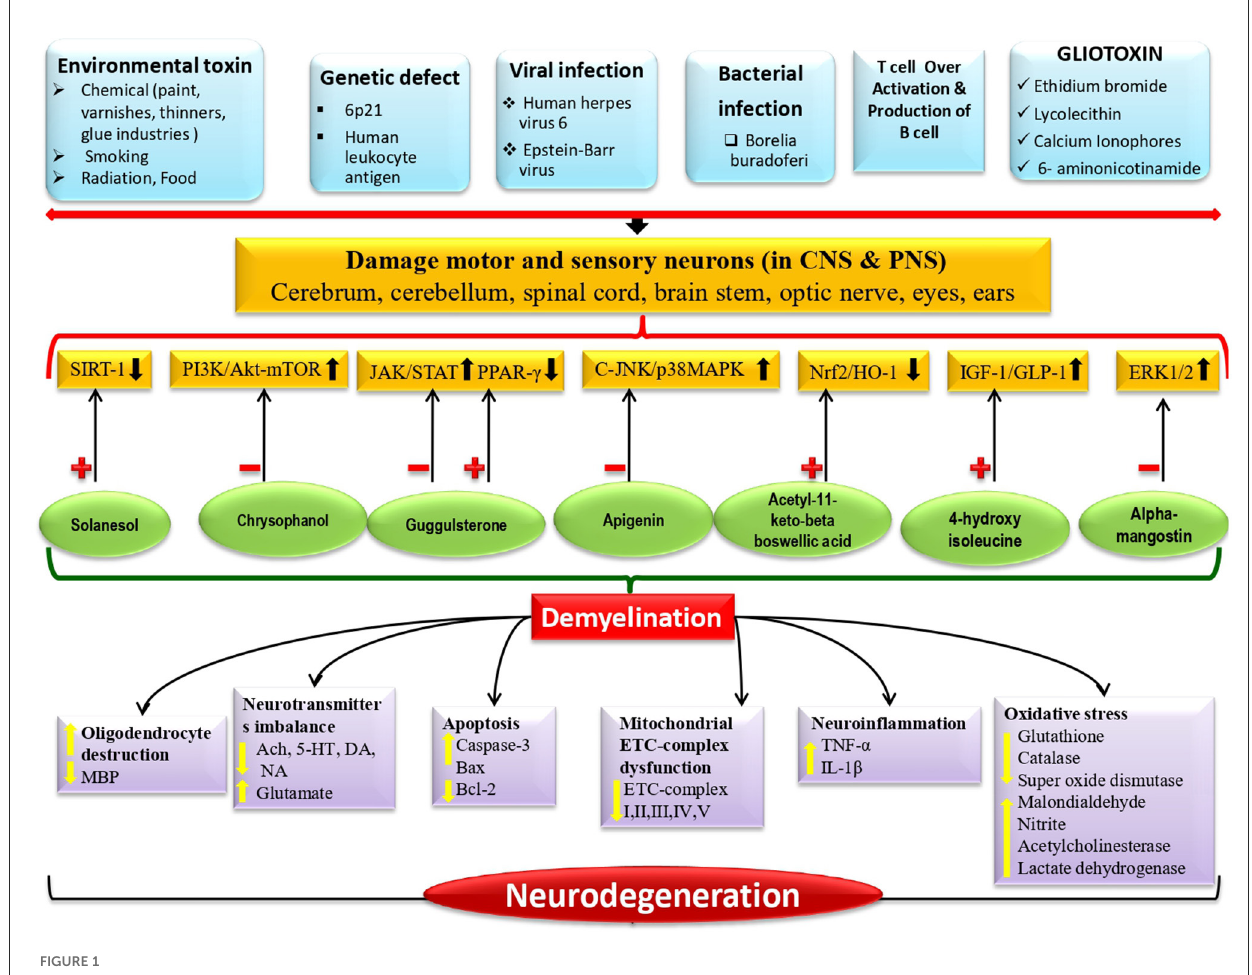
FIGURE1 Role of therapeutic modulators by targeting cellular and molecular